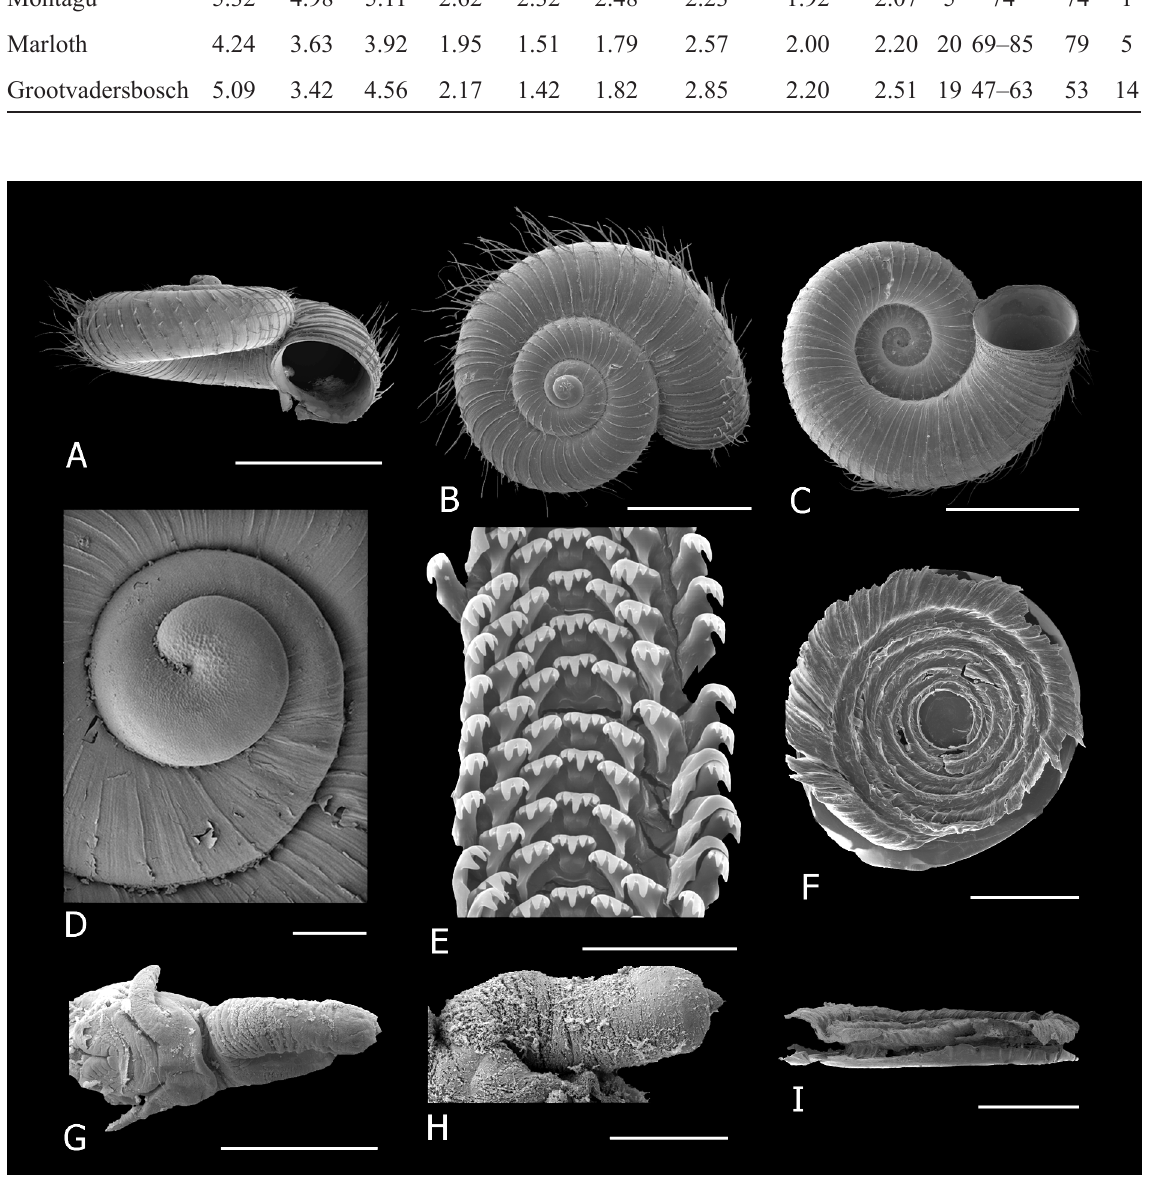
Fig. 25. Chondrocyclus langebergensis sp. nov. A . Aperture view (NMSA W1043/T4117). B . Dorsal view (NMSA W5008/T4119). C . Ventral view (NMSA W5008/T4119). D . Protoconch (ELM W3614/ T96). E . Portion of radula (NMSA W5008/T4119). F . Operculum, dorsal view (ELM W3614/T96). G . Penis, dorsal view showing position behind right tentacle (ELM W3660/T91). H . Penis, lateral view (NMSA W5008/T4119). I . Operculum, lateral view (NMSA W5008/T4119). Scale bars: A–C = 2 mm; D = 200 µm; E = 50 µm; F, I = 500 µm; G–H = 1 mm.